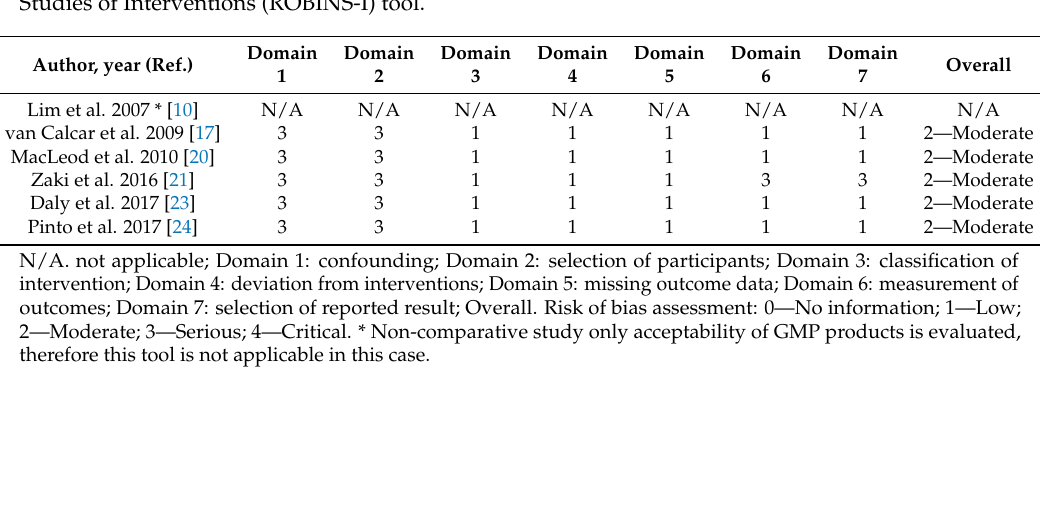
Table 5. Risk of bias in non-randomised studies according to the Risk of Bias in Non-Randomised Studies of Interventions (ROBINS-I)